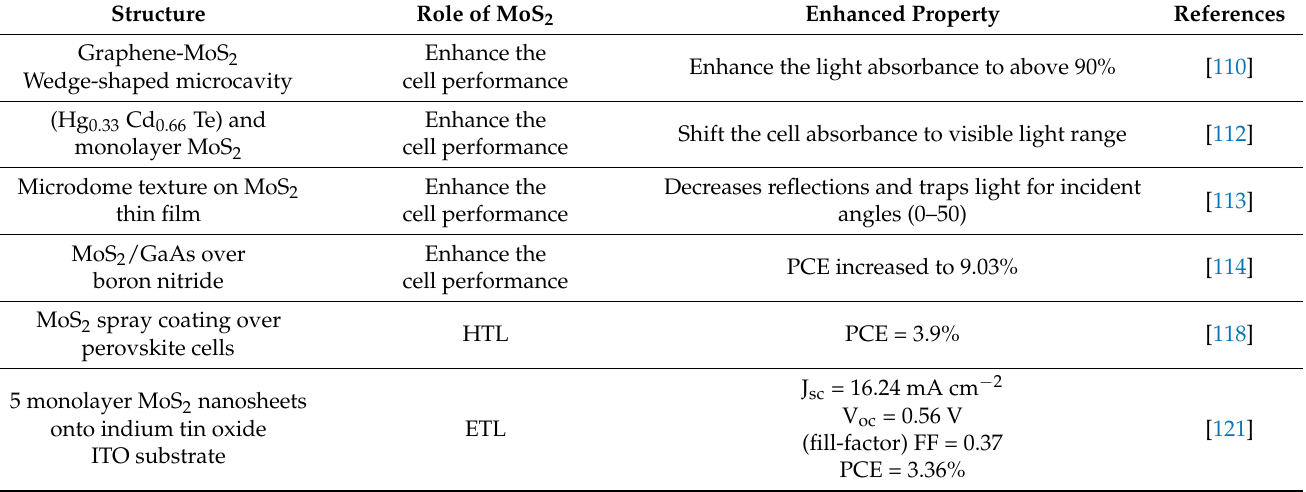
Table 4. MoS 2 applications in solar